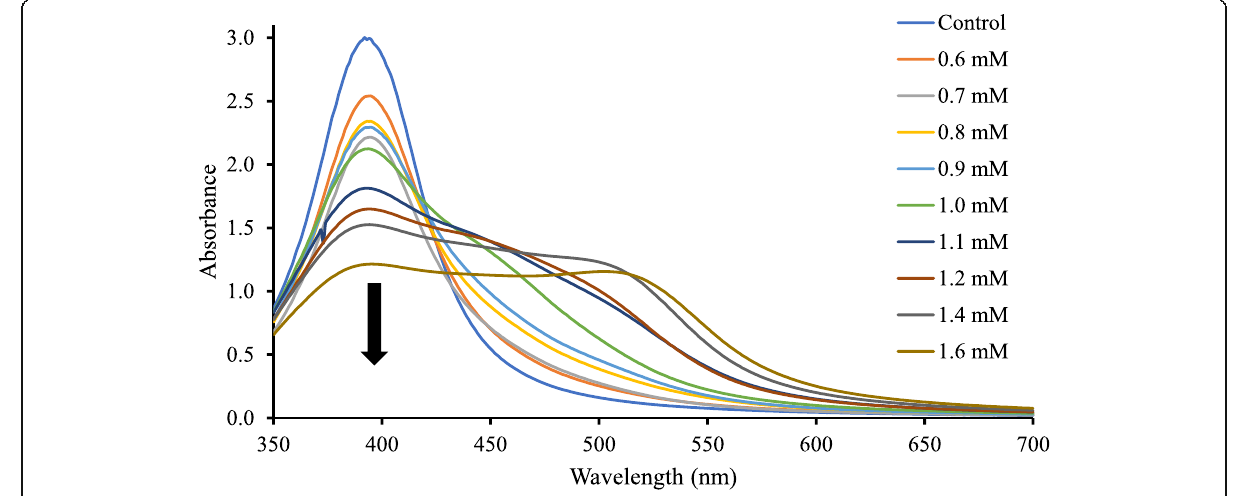
Fig. 5 Absorbance curve changes showing broadening of surface plasmon absorption band